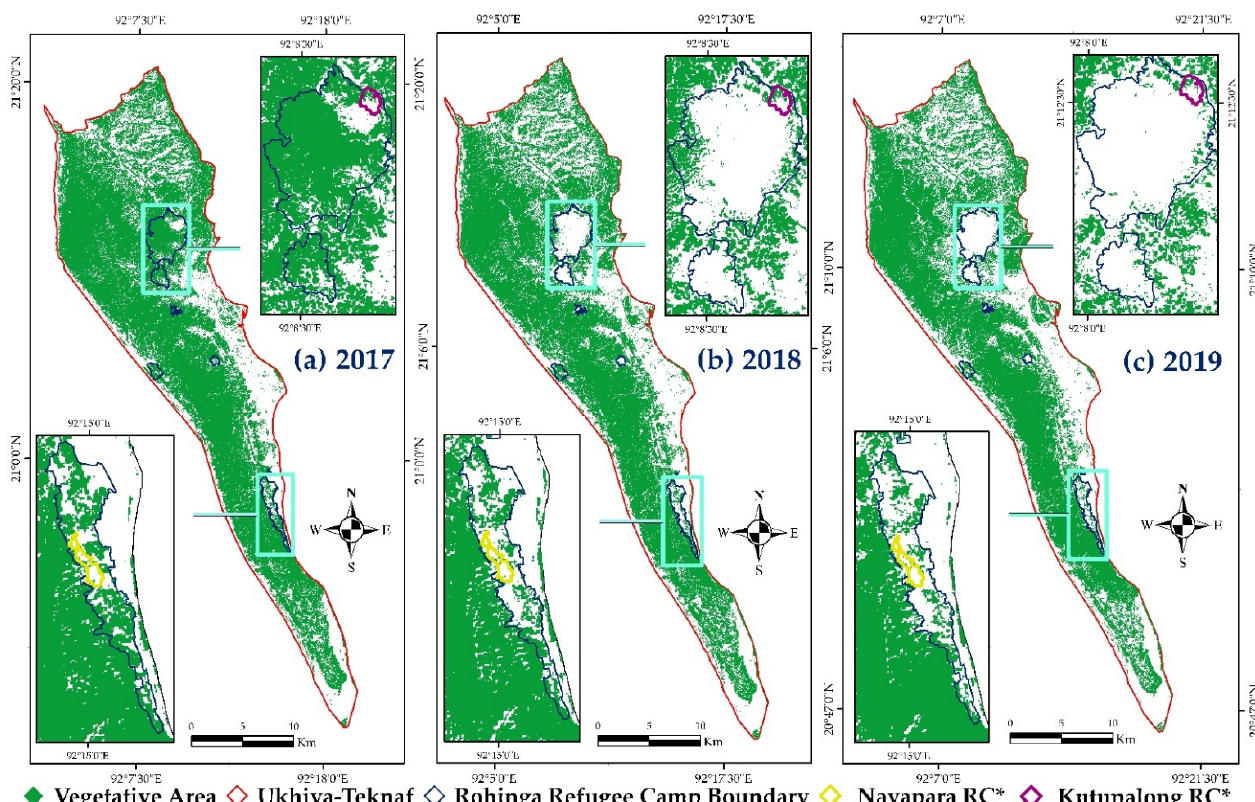
Figure 12. Changes of vegetative cover, Ukhiya-Teknaf, 2017–2019. ( a ) 2017; ( b ) 2018; and ( c ) 2019 (Out of 34 refugee camps there are only two registered refugee camps, which is indicated by the symbol *).